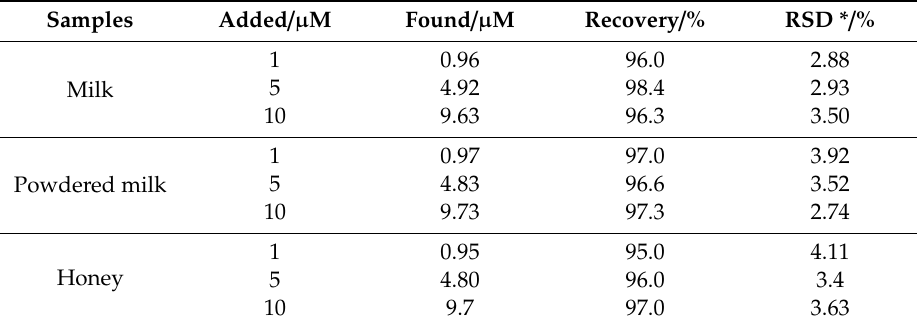
Table 2. Determination of spiked CAP in food samples using CNTs / PDA /